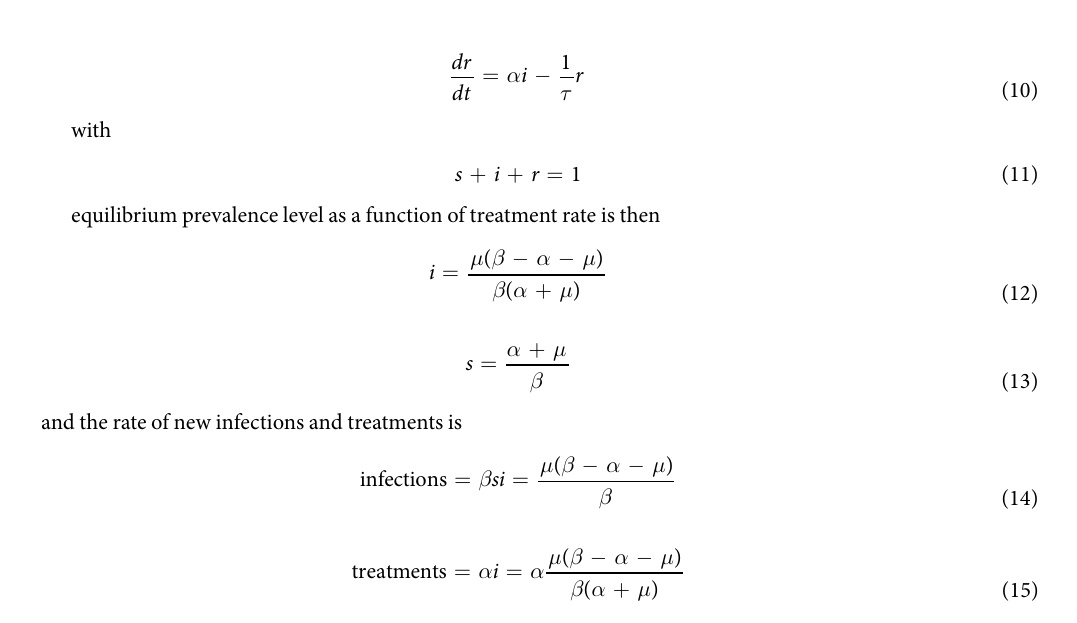
Figure 7. Cumulative number of cases of liver disease progression states as a function of treatment level, calculated for a population of 1000 PWID for infections occurring over a 20 year timespan. The credible intervals given here are for 100 simulations; disease progression follows the age-dependent probabilities of 40 exactly. The lines are discontinuous because disease progression parameters are age-dependent and sometimes differ strongly between age